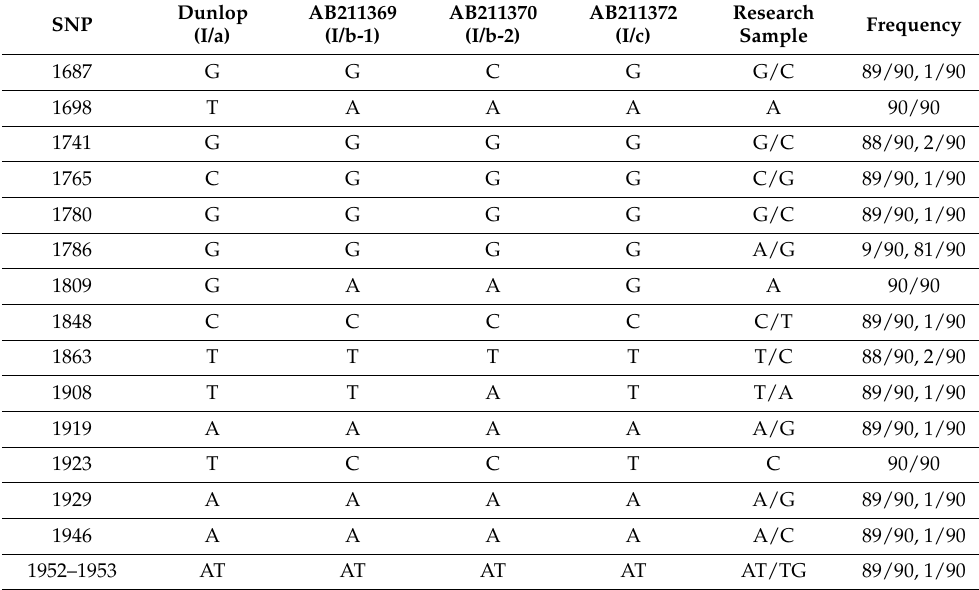
Table 8. SNP positions among BKV-I subgroups in the VP1 gene